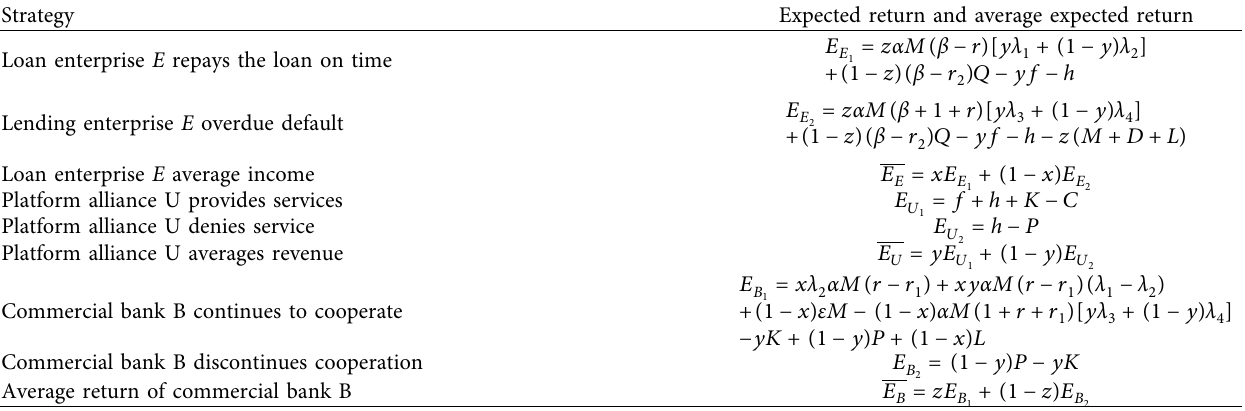
Table 3: Income statement of different strategies of stakeholders.